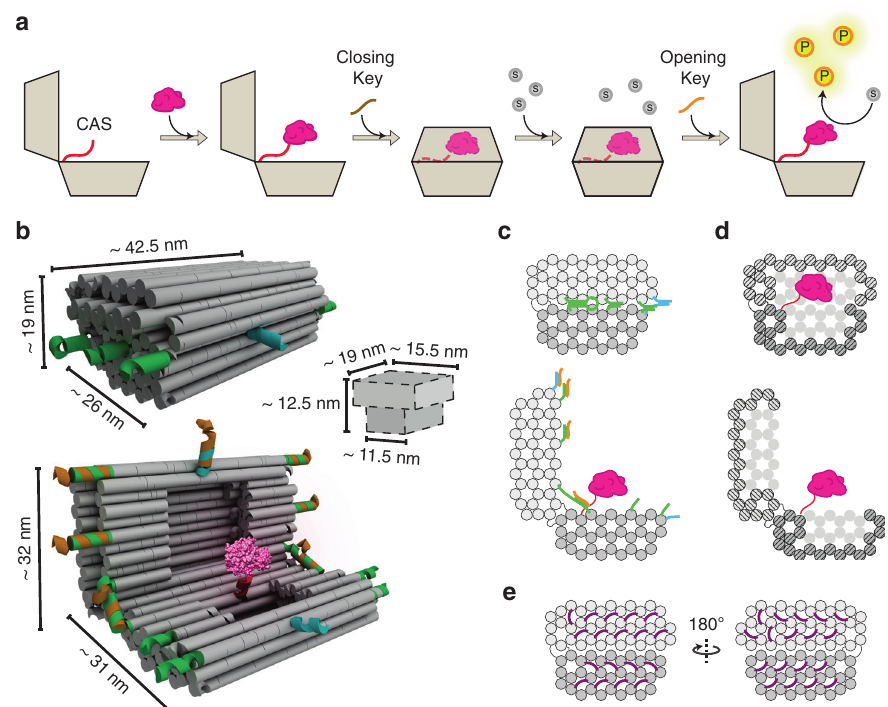
Fig. 1 Working mechanism and structural design of the DNA Vault. a The open nanostructure is loaded with the enzyme (pink) at the cargo-anchoring site (CAS, red) and then closed by adding a sequence-speci fi c closing key (brown). When the substrate (grey circles) is added, the encapsulated enzyme is inhibited from substrate interaction, unless a sequence-speci fi c opening key (orange) is present in solution. Product (yellow circles) is now generated. b Three-dimensional rendering and size of the DNA Vault (DV) in the closed and open states. Cavity of closed structure is schematized. The front lock (cyan), side locks (green), CAS (red) and opening key (orange) are shown. The enzyme shown in pink is bovine alpha-chymotrypsin (aCt, PDB id: 1YPH). c Schematic side-view of enzyme-loaded DV in the closed (top) and open (bottom) states. The DNA helices are visualised as circles. Elements have same colour as in b . d Schematic section-view showing the inner cavity of the enzyme-loaded DV in the closed (top) and open (bottom) states. e End-views showing positions of staple loops (not shown in b for clarity) that cover holes in honeycomb